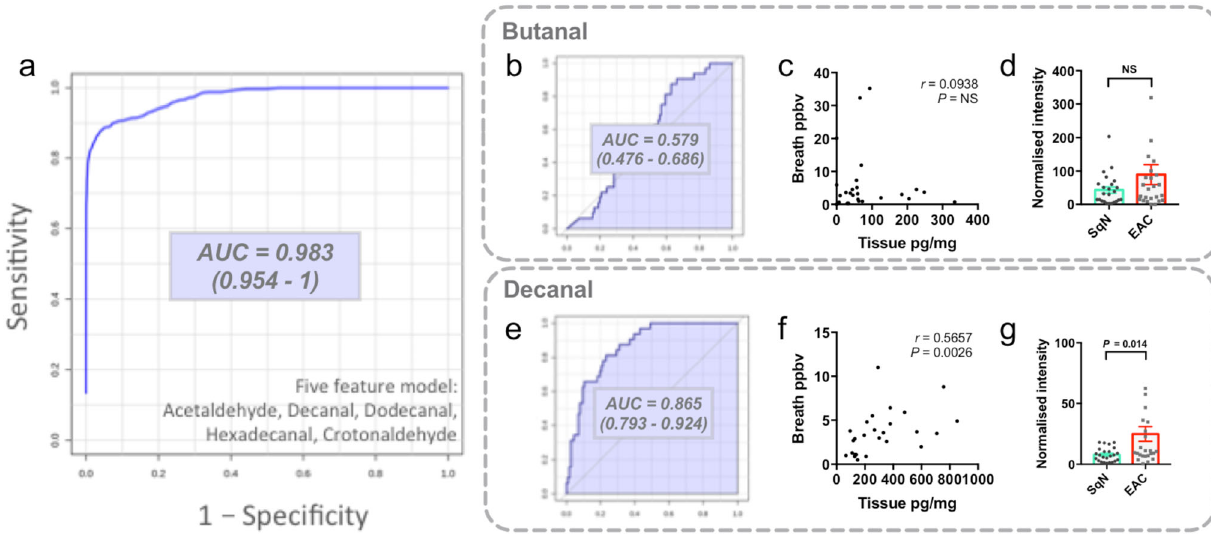
Fig. 4 Tissue decanal is diagnostic and correlates to exhaled decanal. a Receiver operating characteristic curve for EAC detection using a random forests multivariable model based on the indicated tissue aldehydes, measured by UPLC-MS/MS. b – g Comparison of tissue and exhaled butanal and decanal. b , e The receiver operating characteristic curve based on tissue butanal ( b ) or decanal ( e ) concentrations as a single biomarker (UPLC-MS/MS cohort). c , f Correlation of EAC tissue butanal ( c ) and decanal ( f ) concentration to the paired exhaled breath concentration (data from Markar et al. 6 ). P values calculated with a two-tailed Spearman test. d , g Gas-phase concentrations of butanal ( d ) and decanal ( g ) in the headspace of healthy squamous (SqN, n = 24) and esophageal adenocarcinoma (EAC, n = 25) samples measured by proton transfer reaction time-of- fl ight mass spectrometry. Mean ± SEM provided with two-tailed Mann – Whitney U test. Source data are provided in the Source Data fi